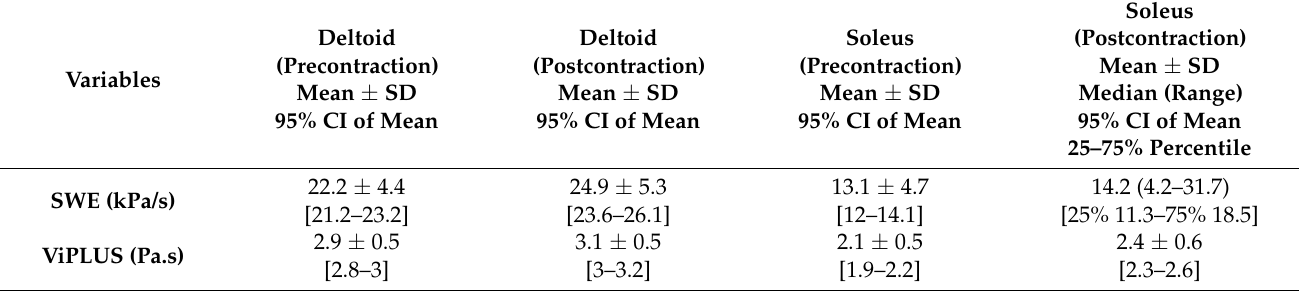
Table 2. Descriptive statistics of muscle mechanical